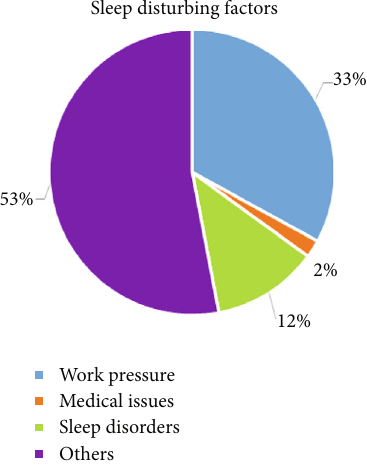
Figure 1: Survey report on sleep